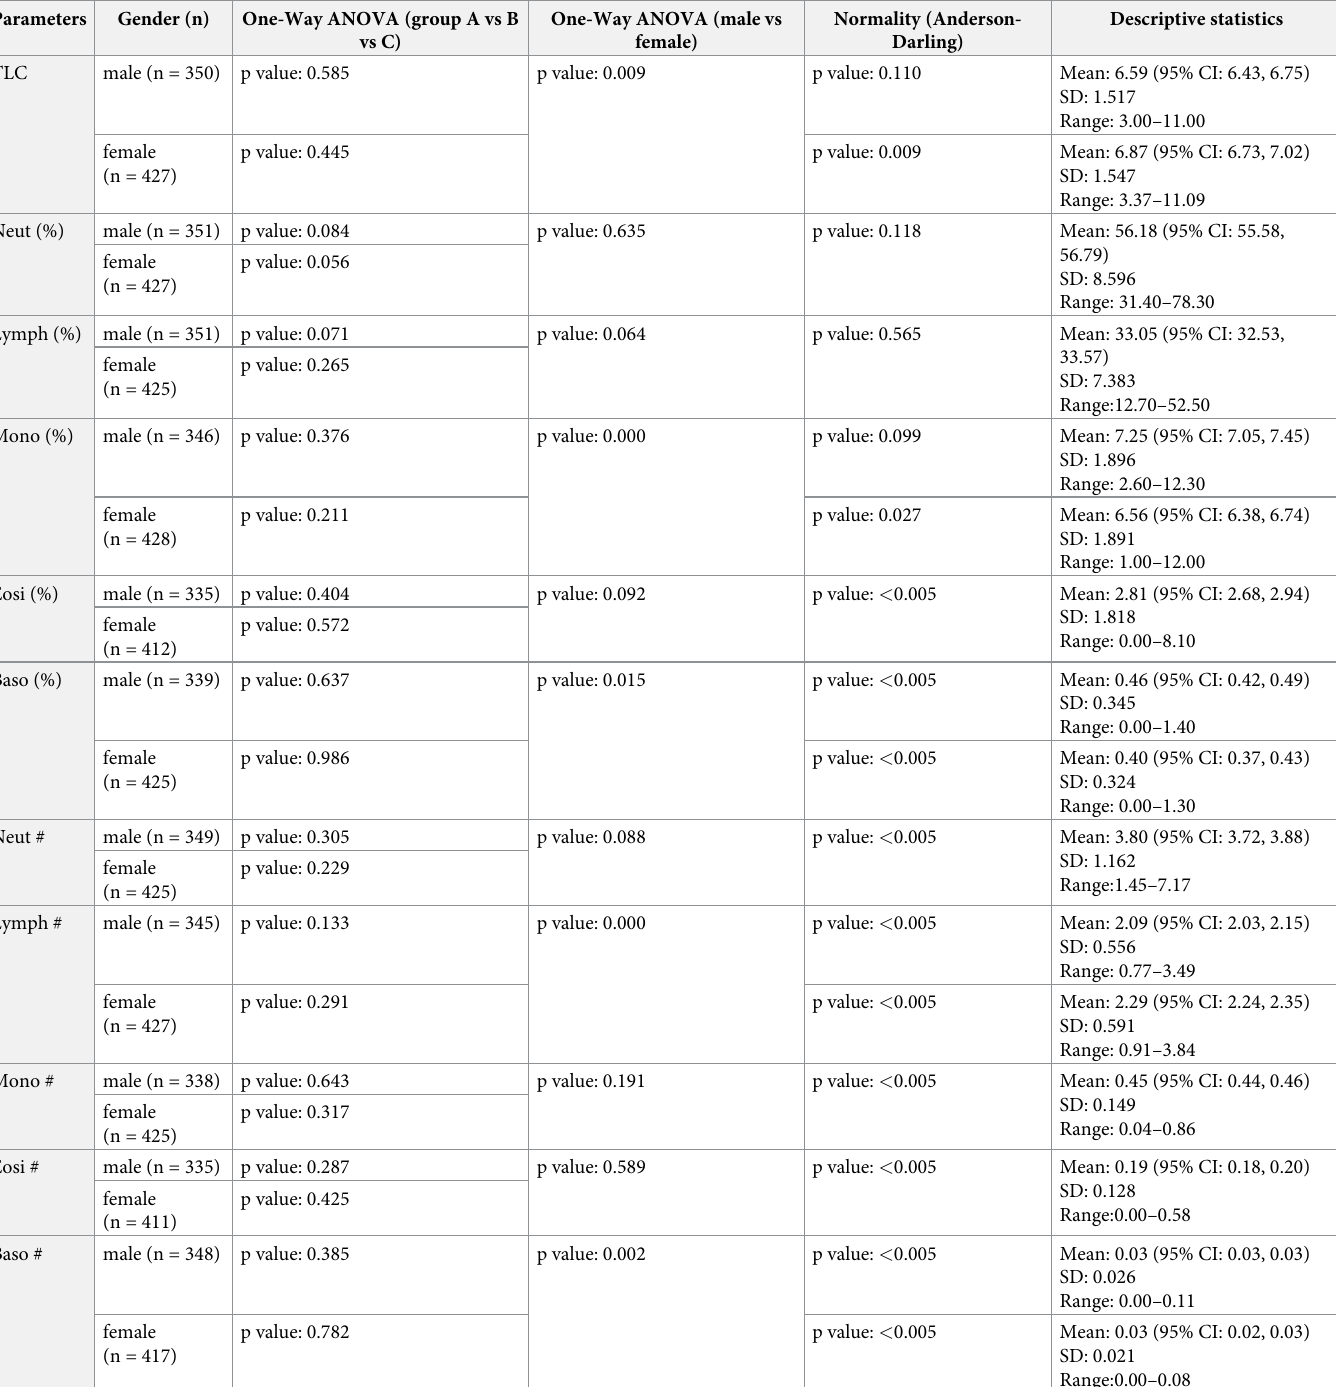
Table 6. The statistical analysis of haematology reference values. The table shows the p-value of one-way ANOVA between sex, age group categories under each sex and descriptive statistics for each haematology parameter.